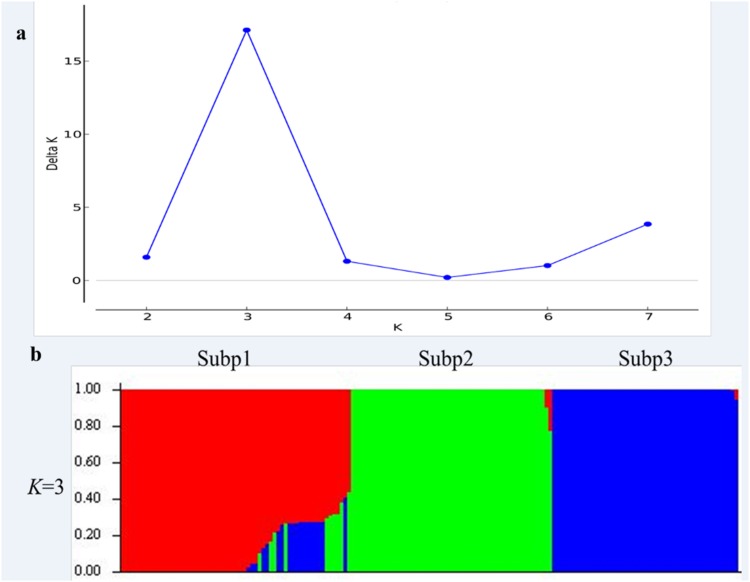
Population structure analysis of 166 cultivars based on unlinked SNP markers.(a) Estimated Δk over three repeats of structure analysis; (b) Three sub-populations inferred by structure analysis. Each of the 166 cultivars is represented by a vertical line and different colors indicate different sub-populations.